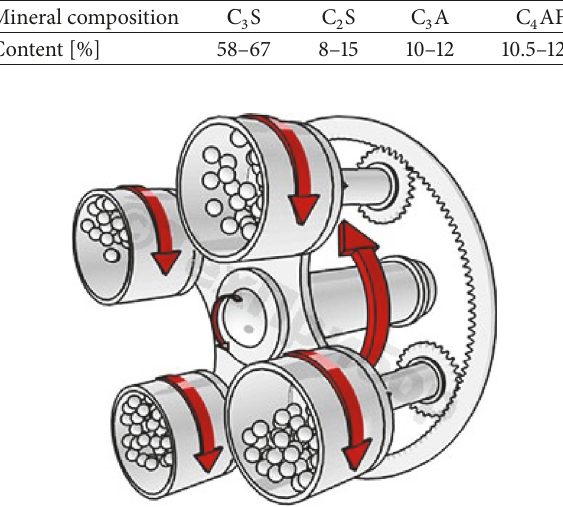
Figure 1: Operating principle of a varioplanetary